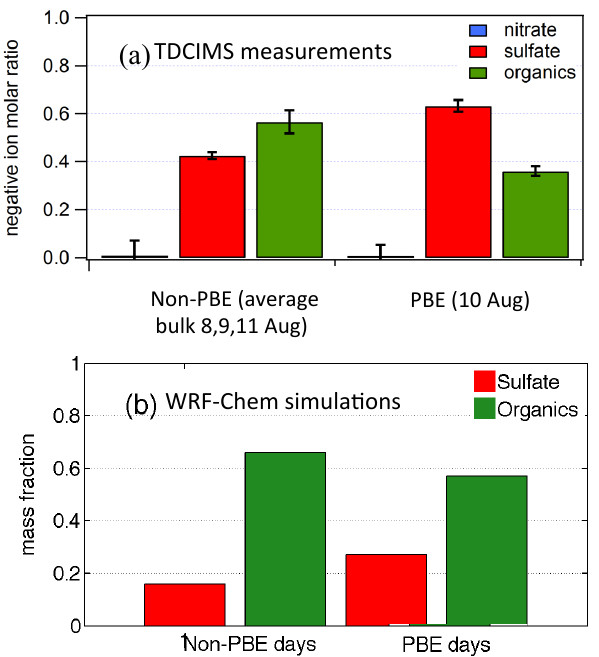
Figure 9. (a) TDCIMS measurements of negative ion molar ratios in bulk submicron aerosols during non-PBE days (8, 9, 11 August) and in 20nm ( ± 0.5nm) particles during a PBE day (10 August). (b) Changes in simulated mass fractions of sulfate and organics in ∼ 20nm particles between PBE days (28, 29 July and 10 August) and non-PBE days (11 and 14 August).